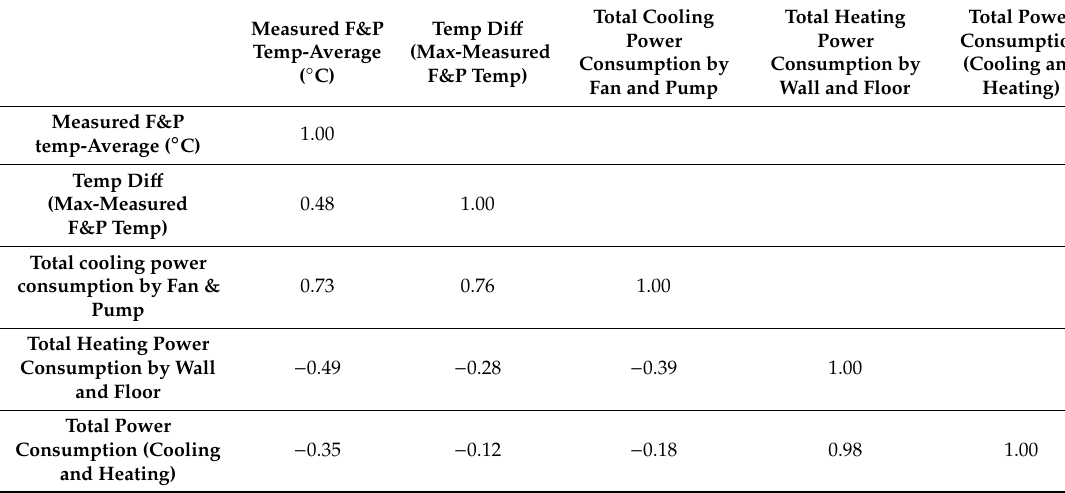
Table A4. Correlation between key variables and measures for the plants cycle.